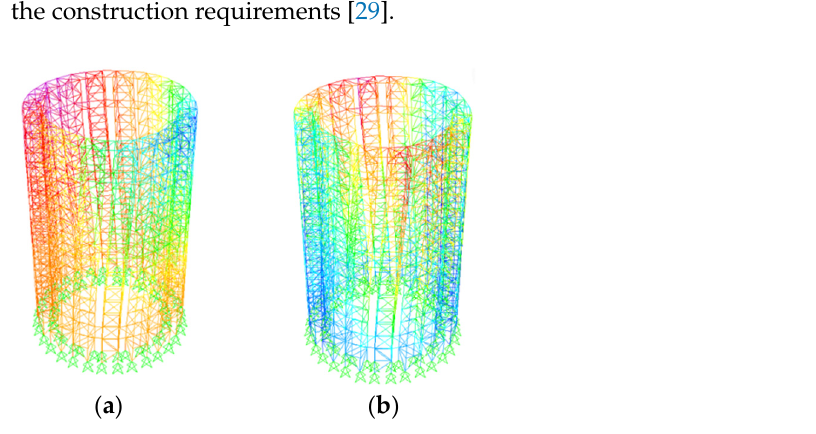
( b ) Figure 17. Cloud diagram of slipper stress and deformation (mm). ( a ) Stress cloud diagram, ( b ) deformation cloud diagram. 5.2. Construction Process of Cable Structure The cable structure’s maximum tension stress and displacement occurred in the last stage. The displacement and stress of the steel structure after tension are shown in Figure 18; the cable structure stress is shown in Figure 19; the vertical displacement of each con- trol node of the rod during the tensile process is shown in Figure 20.